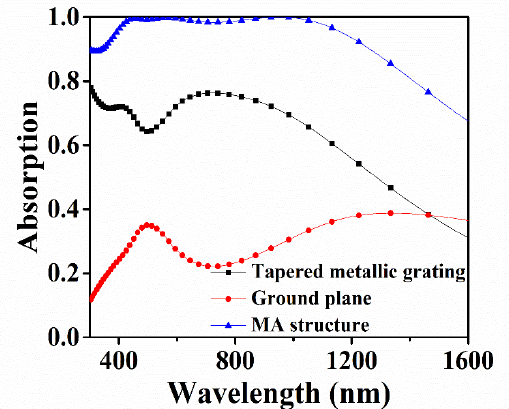
Figure 6. Absorption ability of the components in the proposed MA structure.